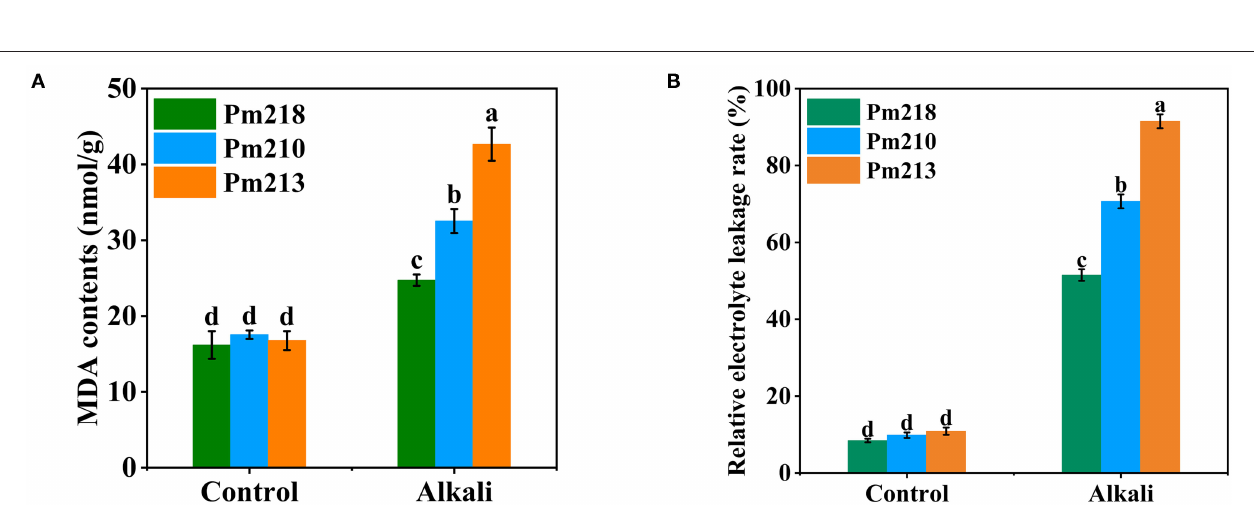
Frontiers in Plant Science |